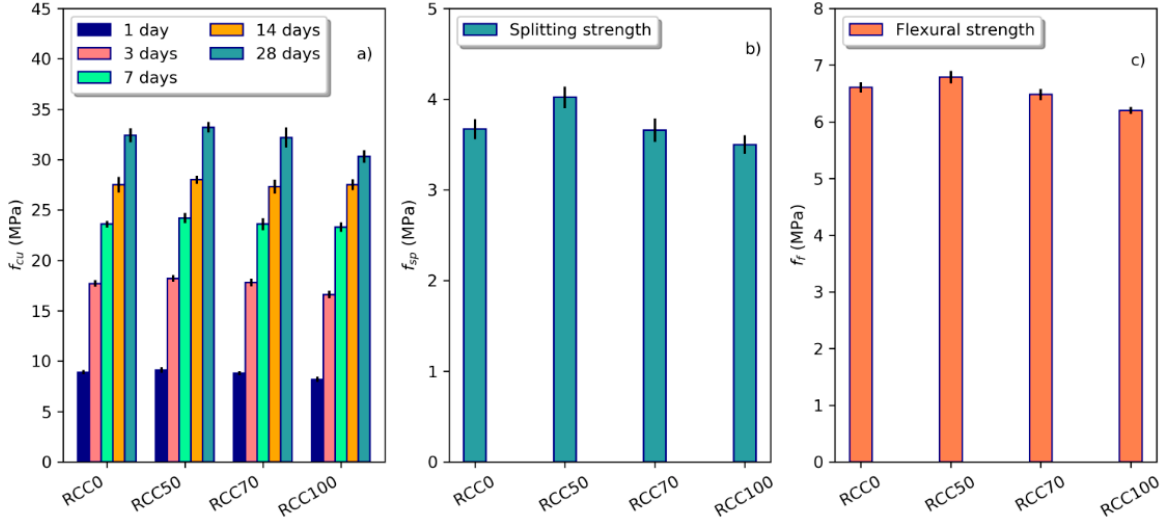
Figure 3. Mechanical properties: ( a ) compressive strength, ( b ) splitting tensile strength, ( c ) flexural strength.